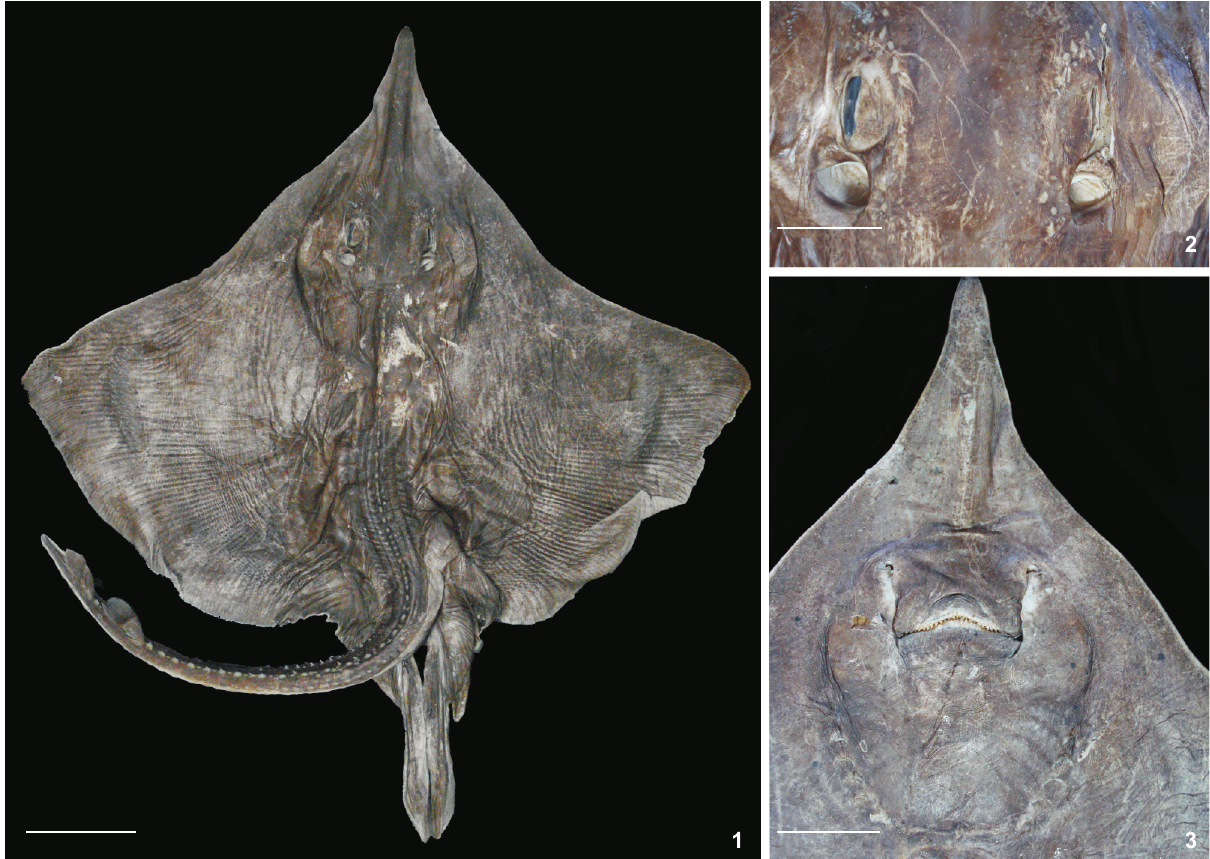
1 = 200 mm, 2 = 50 mm, 3 = 100